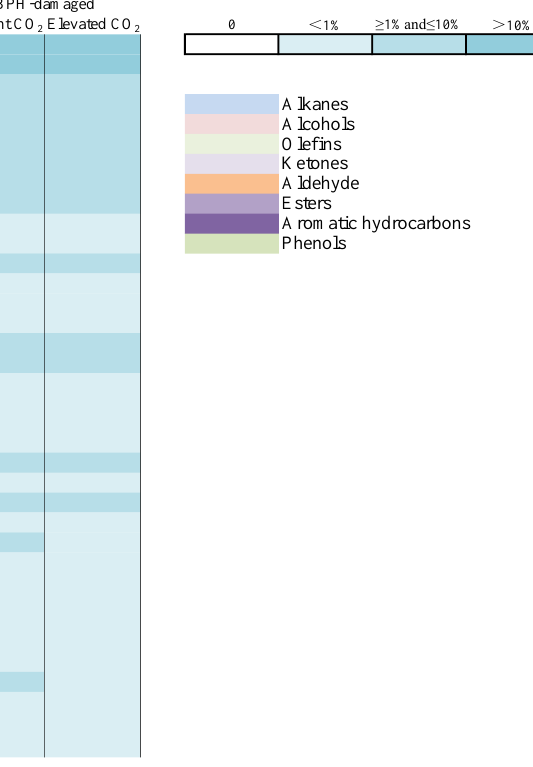
Figure 4. Percentage composition (%) of thirty-six kinds of volatile organic compounds (VOCs) in the healthy (CK) and BPH-damaged rice plants grown under ambient and elevated CO 2.